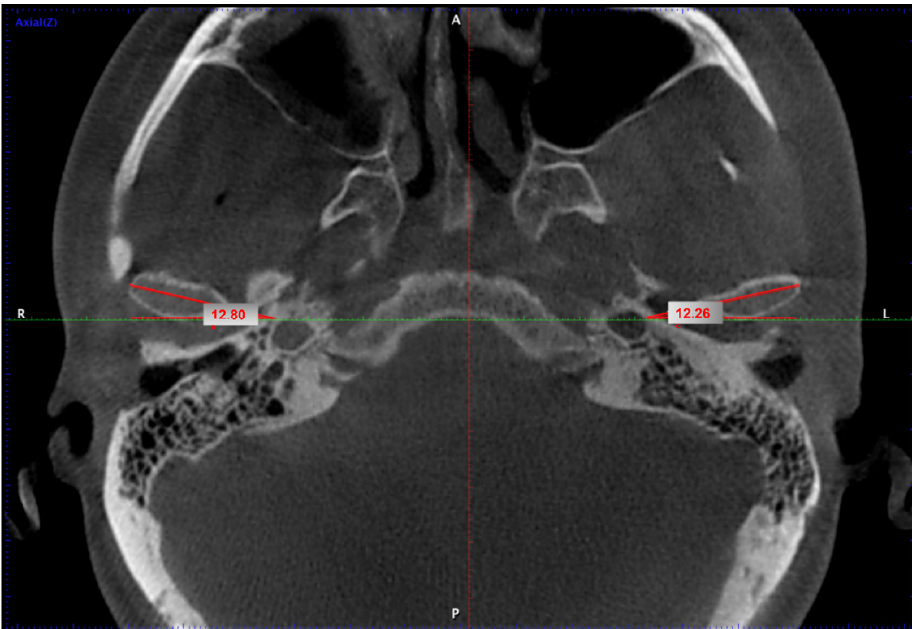
Figure 3. CBCT axial section. The measurements of the condyle angle performed in its largest diameter related to the transversal plane.